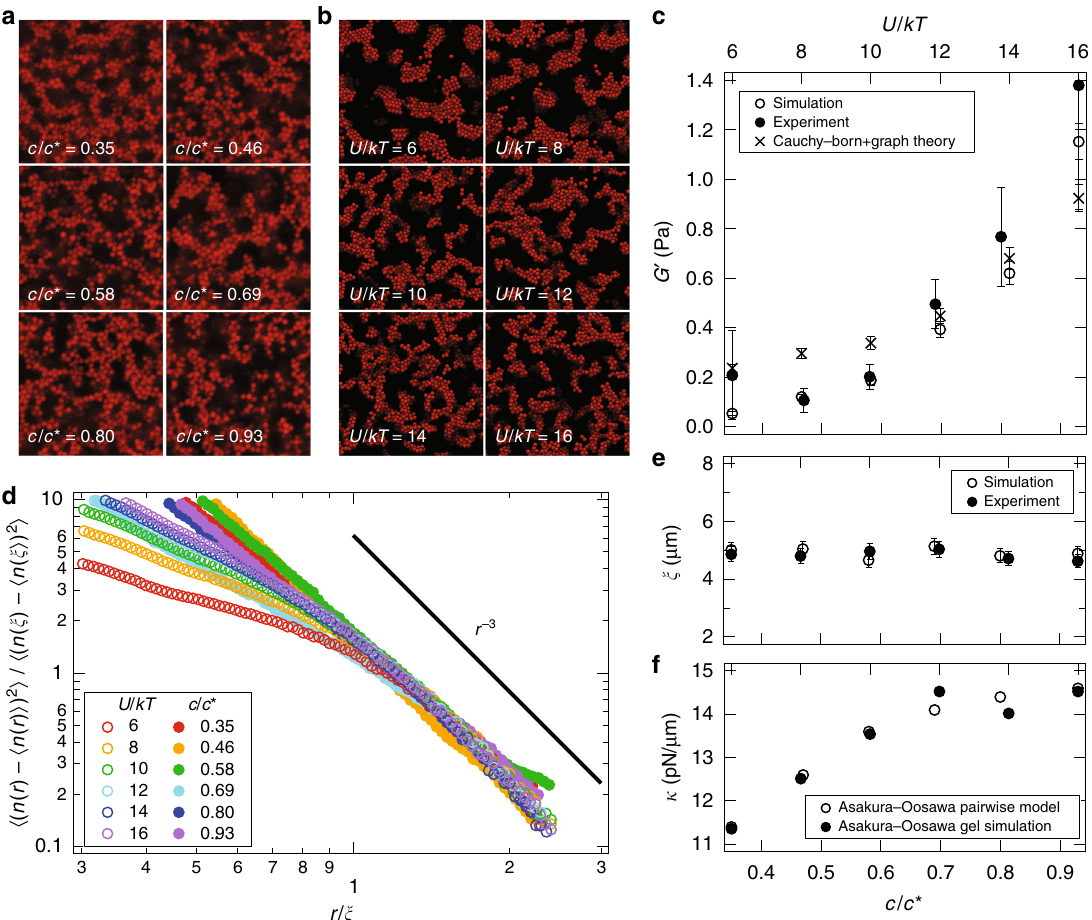
Fig. 1 The microstructure and rheology of simulated and experimental gels. a Confocal micrographs and b simulation snapshots of depletion gels at different polymer concentration and fi xed volume fraction ϕ = 0.20. c The elastic modulus of depletion gels measured in experiment (solid) and computed via simulation (open) as a function of depletant concentration and strength of attraction. The predictions of the graph-decomposition and Cauchy-Born theory (crosses) compare well with the measurements. The error bars of the experiments are calculated from three independent measurements. Similarly, the error bars for the simulations are the 95% con fi dence intervals from data collected across multiple gels under the same conditions. The frequency dependence of the experimental and simulated shear moduli are discussed in Supplementary Note 1 and compared in Supplementary Fig. 1. d Variance in the number density of particles within a spherical boundary of radius r measured from experiments (solid) and simulations (open). The solid line is a power-law decay for a geometrically dense structure. e The characteristic correlation length of number density fl uctuations measured in experiments (solid) and computed via simulations (open). f The stiffness of inter-particle bonds computed from the Asakura-Oosawa theory and direct application of the equipartition theorem (open) or measured directly in simulations of arrested